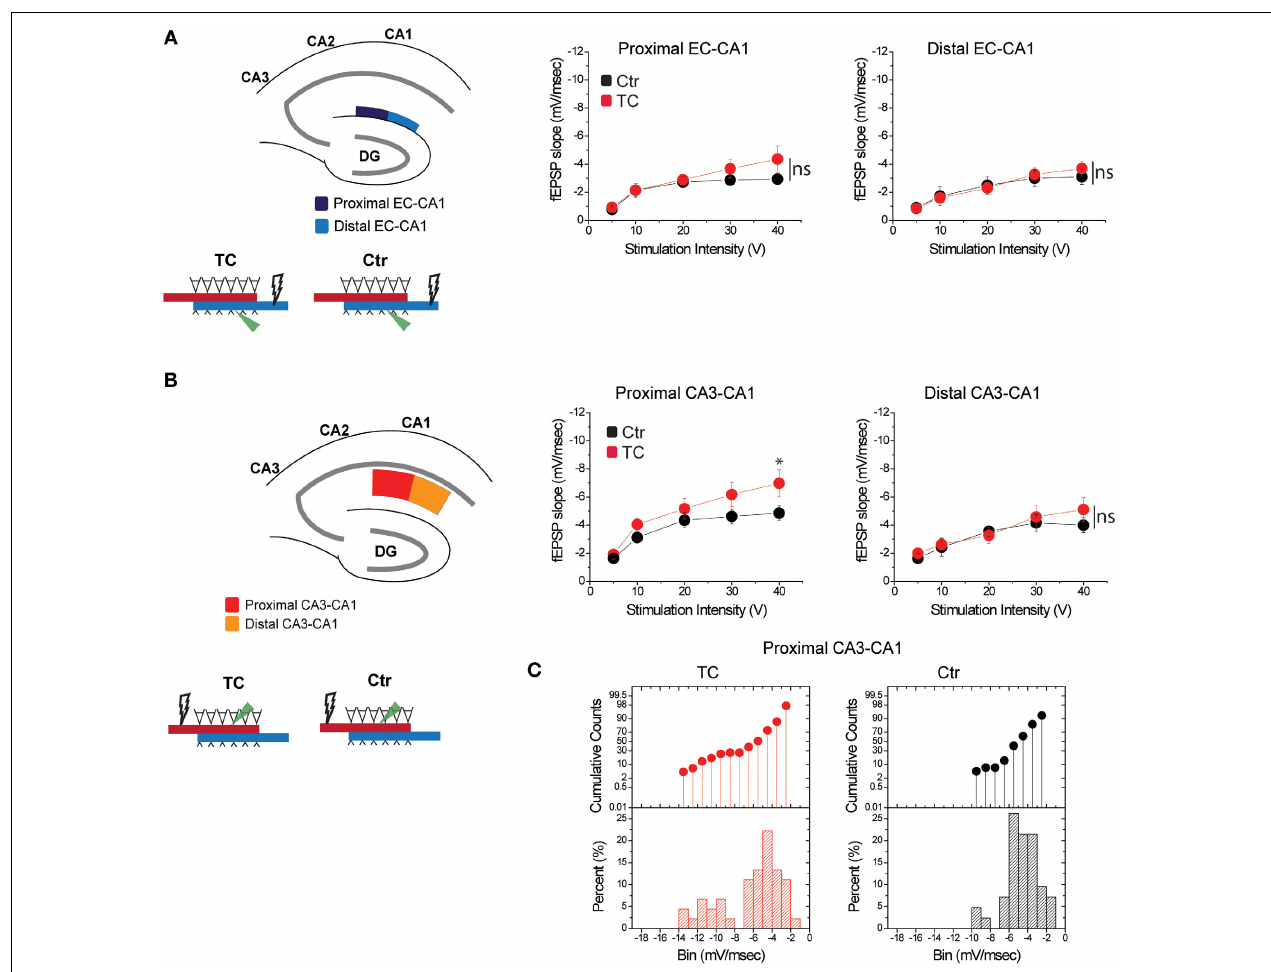
not distal CA3-CA1 path. Data points represent mean ± s.e.m. (C) .The cumulative counts (top) and the percentage (bottom) of slice recordings within given ranges (bins) of fEPSP slope amplitude in the proximal CA3-CA1 synaptic path show that about 20% of recorded slices from TC rats distribute over higher fEPSP slope amplitudes (left) compared to the Ctr group that mostly distribute between − 2 and − 6mV/ms (right). The distribution of fEPSP amplitude across slices is representative of each individual